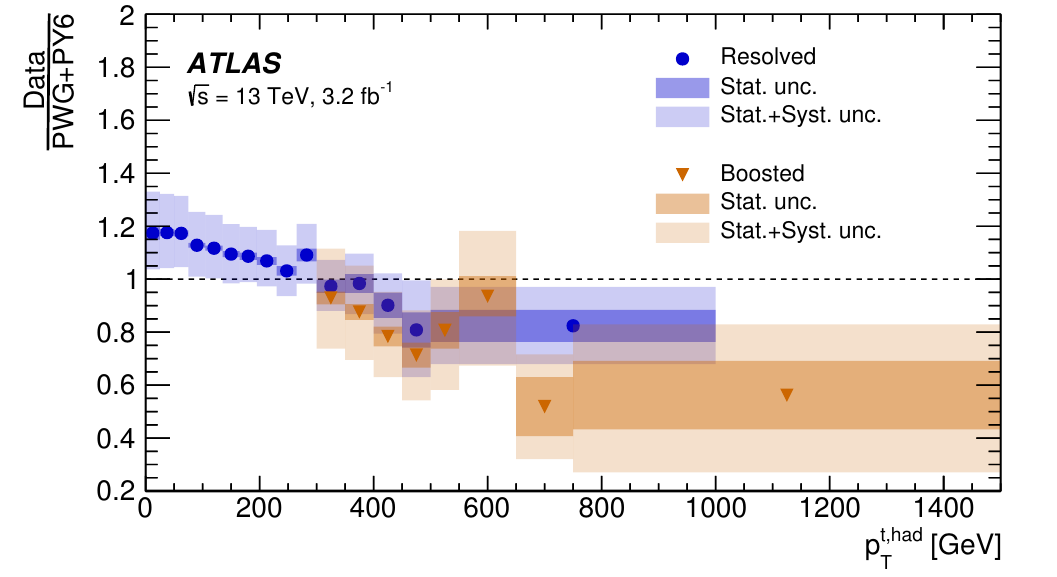
Figure 19. Ratios of the measured (cid:12)ducial phase-space absolute di(cid:11)erential cross-section to the prediction from Powheg + Pythia6 in the resolved and boosted topologies as a function of their respective transverse momentum of the hadronic top quark. The bands indicate the statistical and total uncertainties of the data in each bin. The Powheg + Pythia6 generator with h damp = m t and the CT10 PDF is used as the nominal prediction to correct for detector